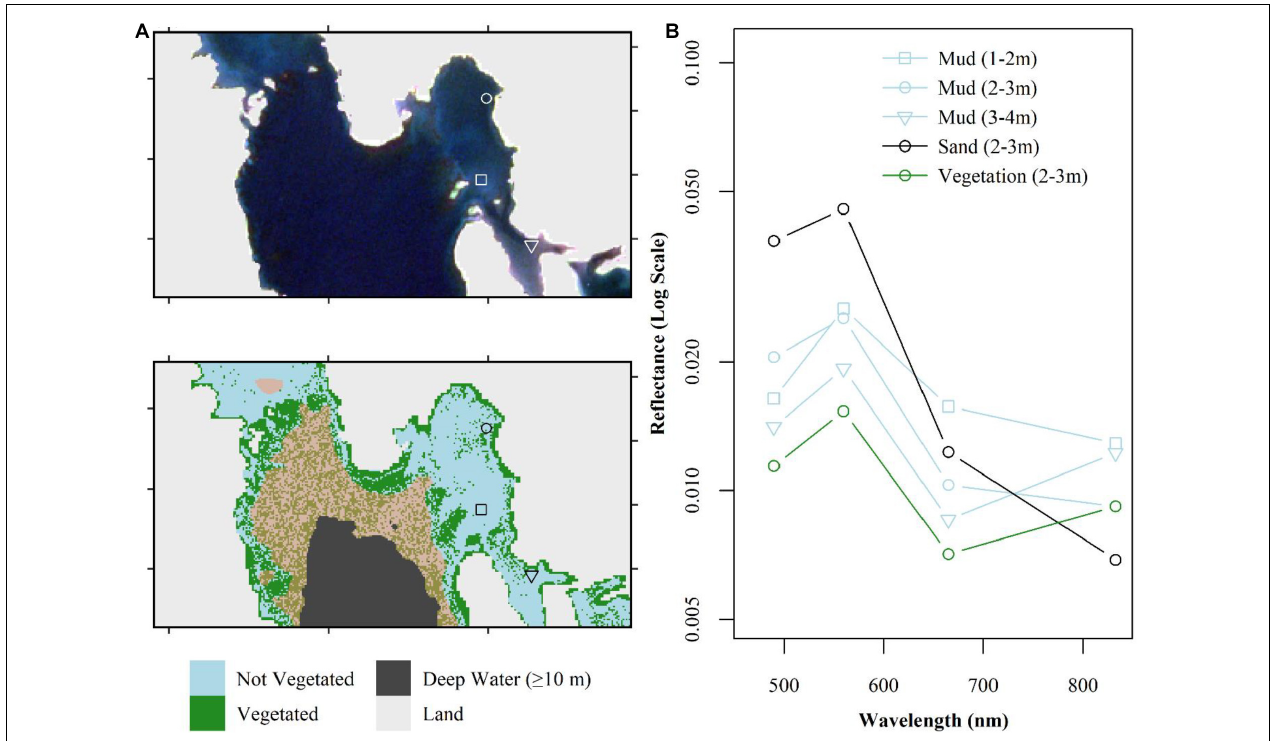
FIGURE 7 | Finalized classification of the Sentinel-2 image from September 13, 2016 highlighting how mud is misclassified at greater depths. (A) True color composite and resulting map classification (thresholded at ≥ 80% probability of being vegetated) indicating location of field survey points of a muddy habitat at 1–2 m (square), 2–3 m (circle), and 3–4 m (triangle). Waters at depth from 5 to 10 m shown with transparent yellow overlay (“brown” in the figure). (B) Spectra for the same three survey points, compared to sand and vegetated dominated habitat at 2–3 m of water